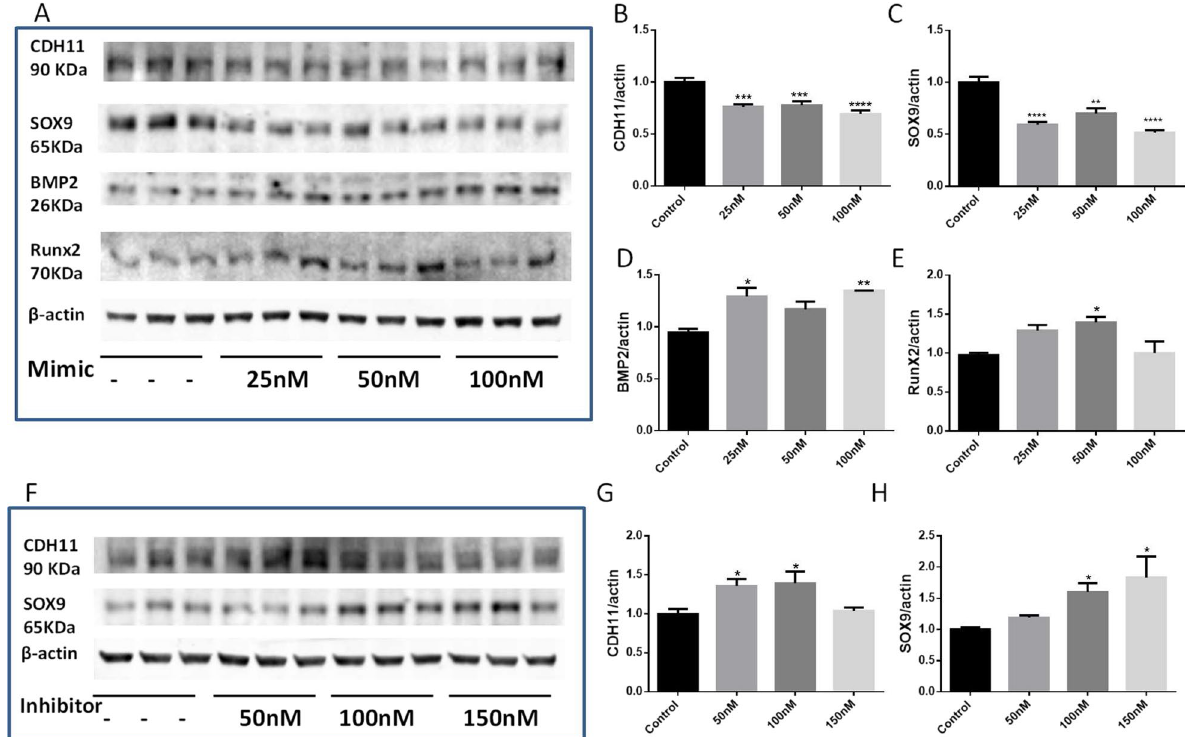
Fig. 3 miR-101-3p regulated CDH11 and Sox9 protein expression and osteogenesis markers BMP2/Runx2 in HAVICs. A Western Blots against antibodies of Cadherin-11 (CDH11) (ab147215), Sox9 (AB5535, Millipore), BMP2 (ThermoFisher, 710022), and Runx2 (Santa Cruz sc-12488) in HAVICs at 72 h after transfection with negative control and various doses of miR-101-3p mimic. B – E Quantification of CDH11, Sox9, BMP2, and Runx2 protein expression normalized with β-actin. F Western Blots against antibodies of Cadherin-11 (CDH11) and Sox9 in HAVICs at 72 h after transfection with negative control and various doses of mir-101-3p inhibitor. G , H Quantification of CDH 11 and Sox9 protein expression normalized with β-actin. Data means SEM. *p < 0.05, **P < 0.01, ***P < 0.001 and ****P < 0.0001 vs Control. n = ±